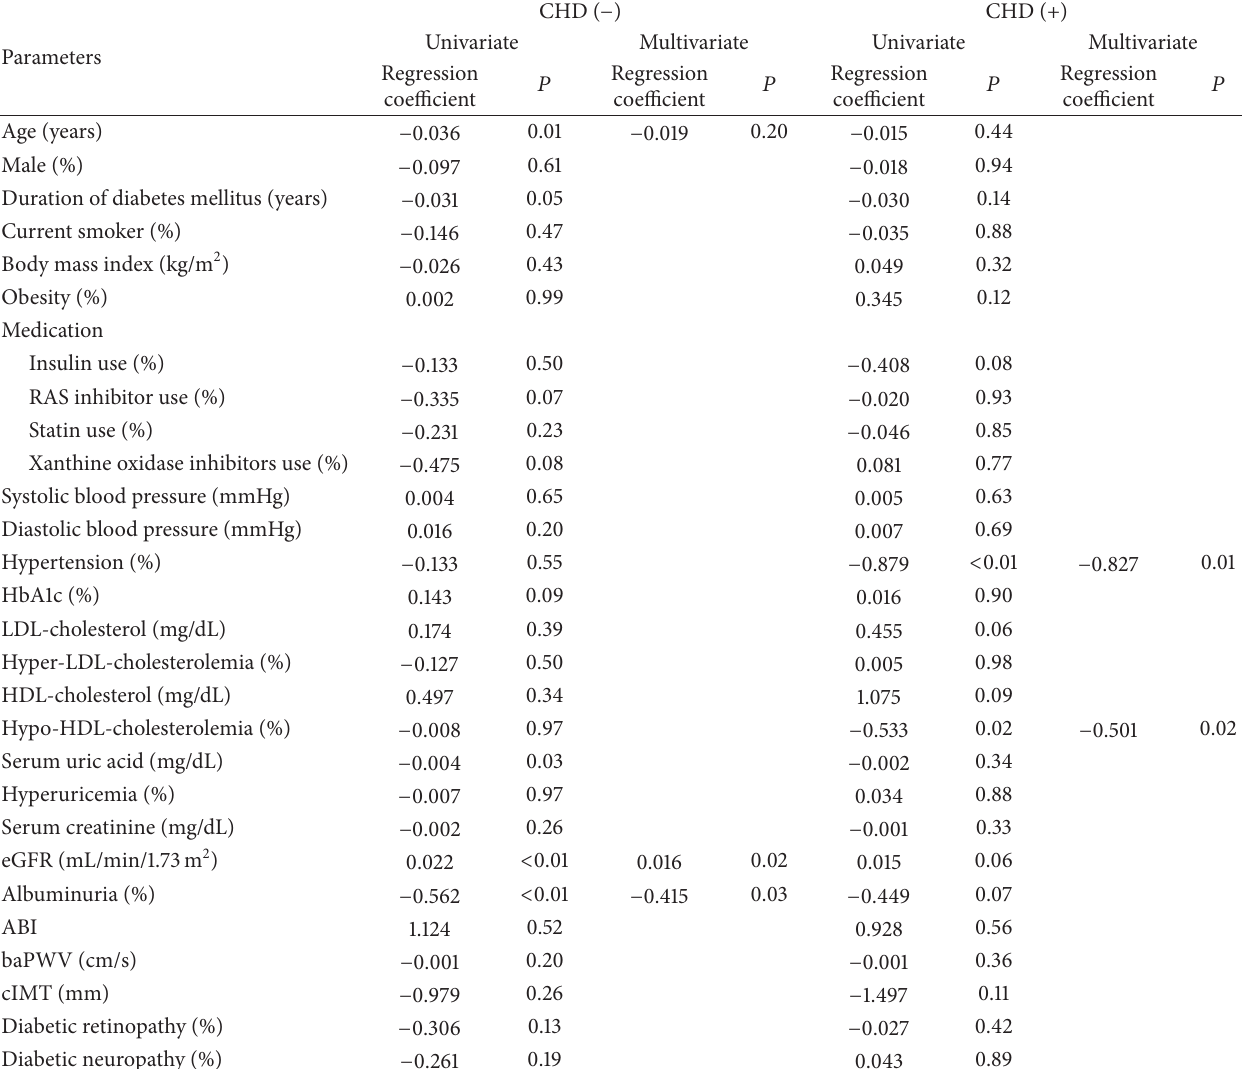
Table 2: The relationship between the FMD and clinical parameters in the type 2 diabetic patients with and without CHD. Parameters